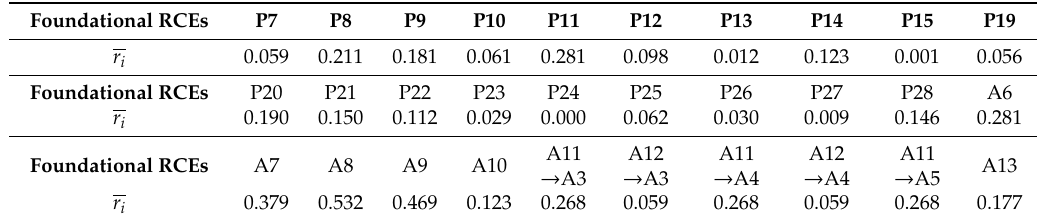
Table 2. The risk of the foundational risk causal elements (RCEs) of the coupling model V3: AR–PR.